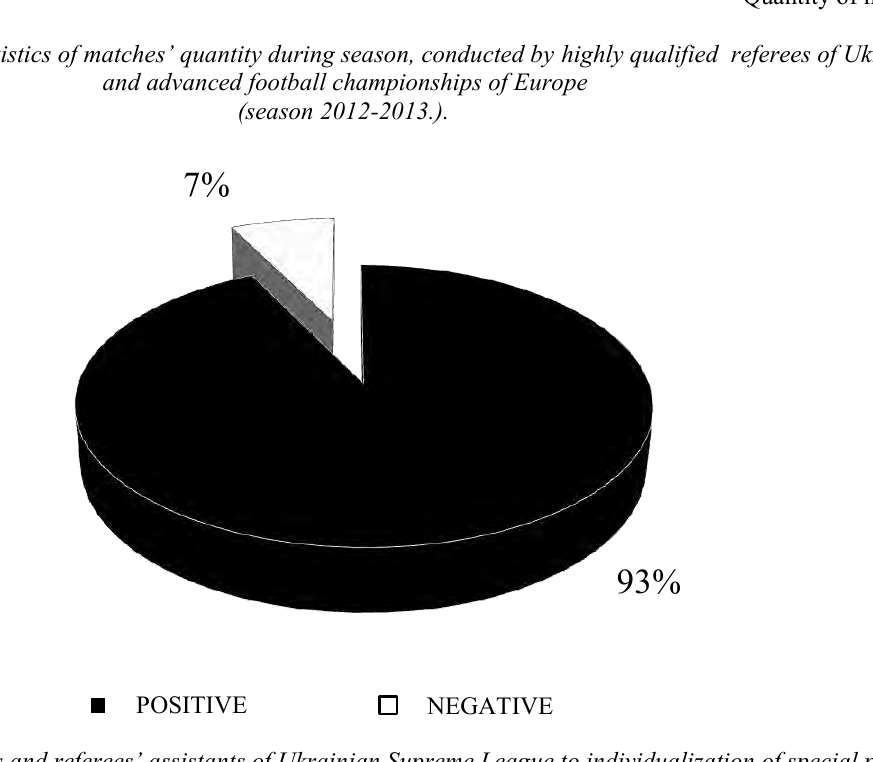
Fig.2. Attitude of referees and referees’ assistants of Ukrainian Supreme League to individualization of special physical